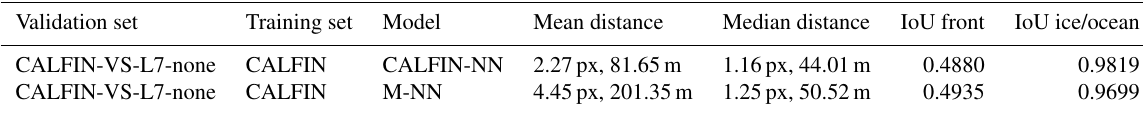
Figure 14. Regional terminus advance and retreat over time. (a) Regional delineations (left) and terminus position graphs (right) for Green- land (b) , as well as the northwestern (c) , central western (d) , central eastern (e) , southeastern (f) , and southwestern (g) regions. Note that the total Greenland mean advance and retreat is unadjusted and dominated by the trend lines of numerous smaller glaciers in CW and NW Greenland. Note that branches in the 66 studied basins are independently counted, for a total of 87 glaciers. Table 2. Model intercomparison error table. Metrics for the CALFIN-NN and M-NN models on all non-Landsat 7 test images in the CALFIN validation